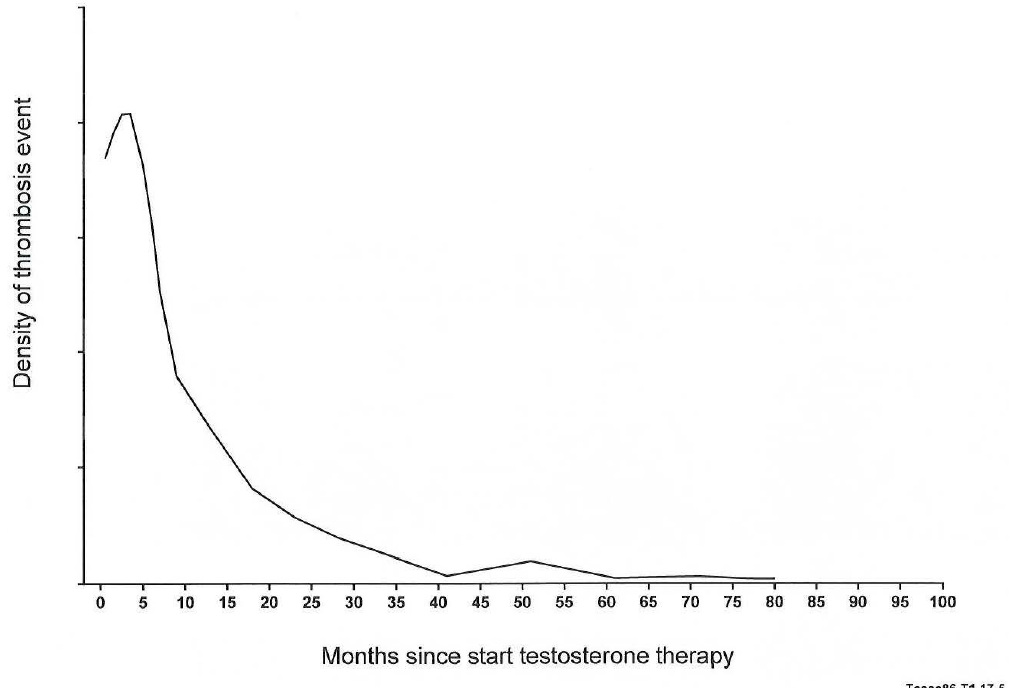
Figure 1. Quadratic spline curve illustrating the density of venous thromboembolism (VTE) events over time since starting testosterone therapy ( n = 88).